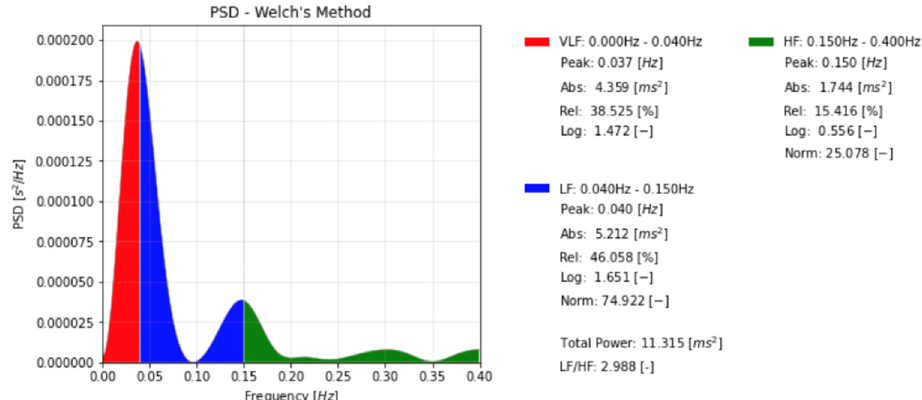
Figure 2. Spectral analysis of heart rate (HR) of a healthy female subject (the same as shown in Figure 1, for more details see Appendix A.4).